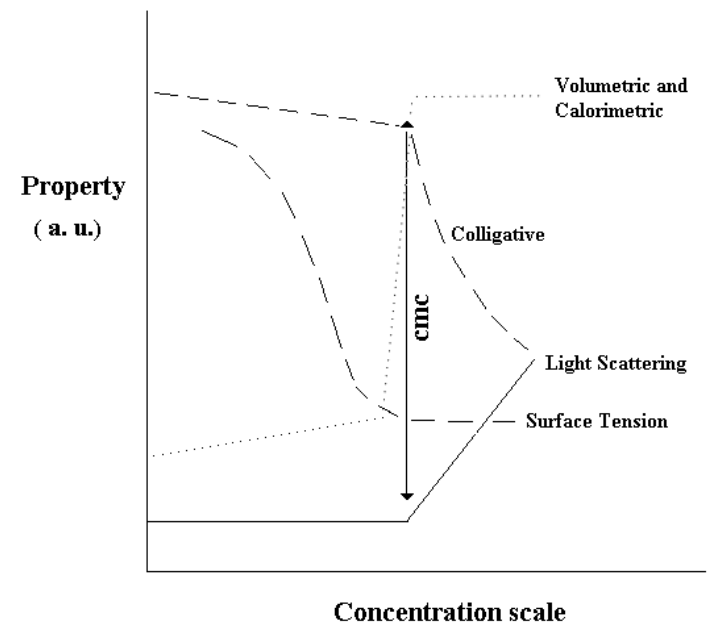
Figure 3. Dependence of some physical-chemical properties on surfactant concentration. The arrow indicates the cmc value, above which micelles dominate. Concentration scales are normal or logarithmic (in surface tension